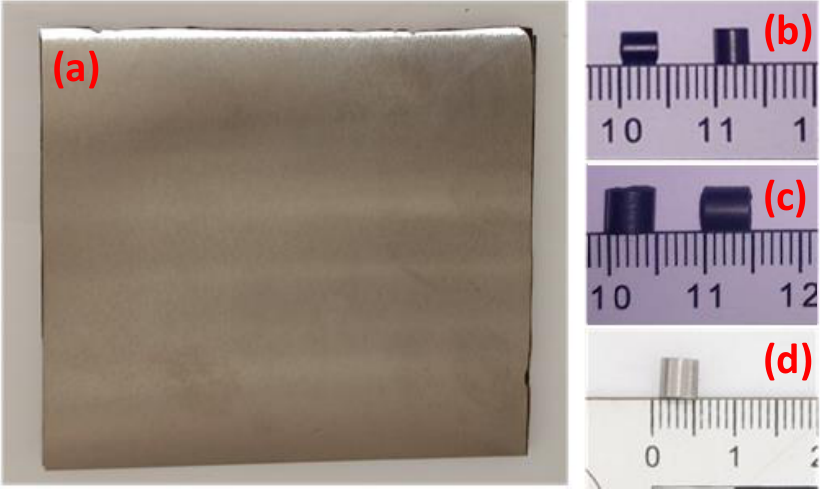
Figure 4. ( a ) 10 mm × 10 mm × 2 mm armour steel plate; ( b ) 3.5 mm MRE fragments; ( c ) 5 mm MRE fragments; ( d ) 4.6 mm steel fragment.